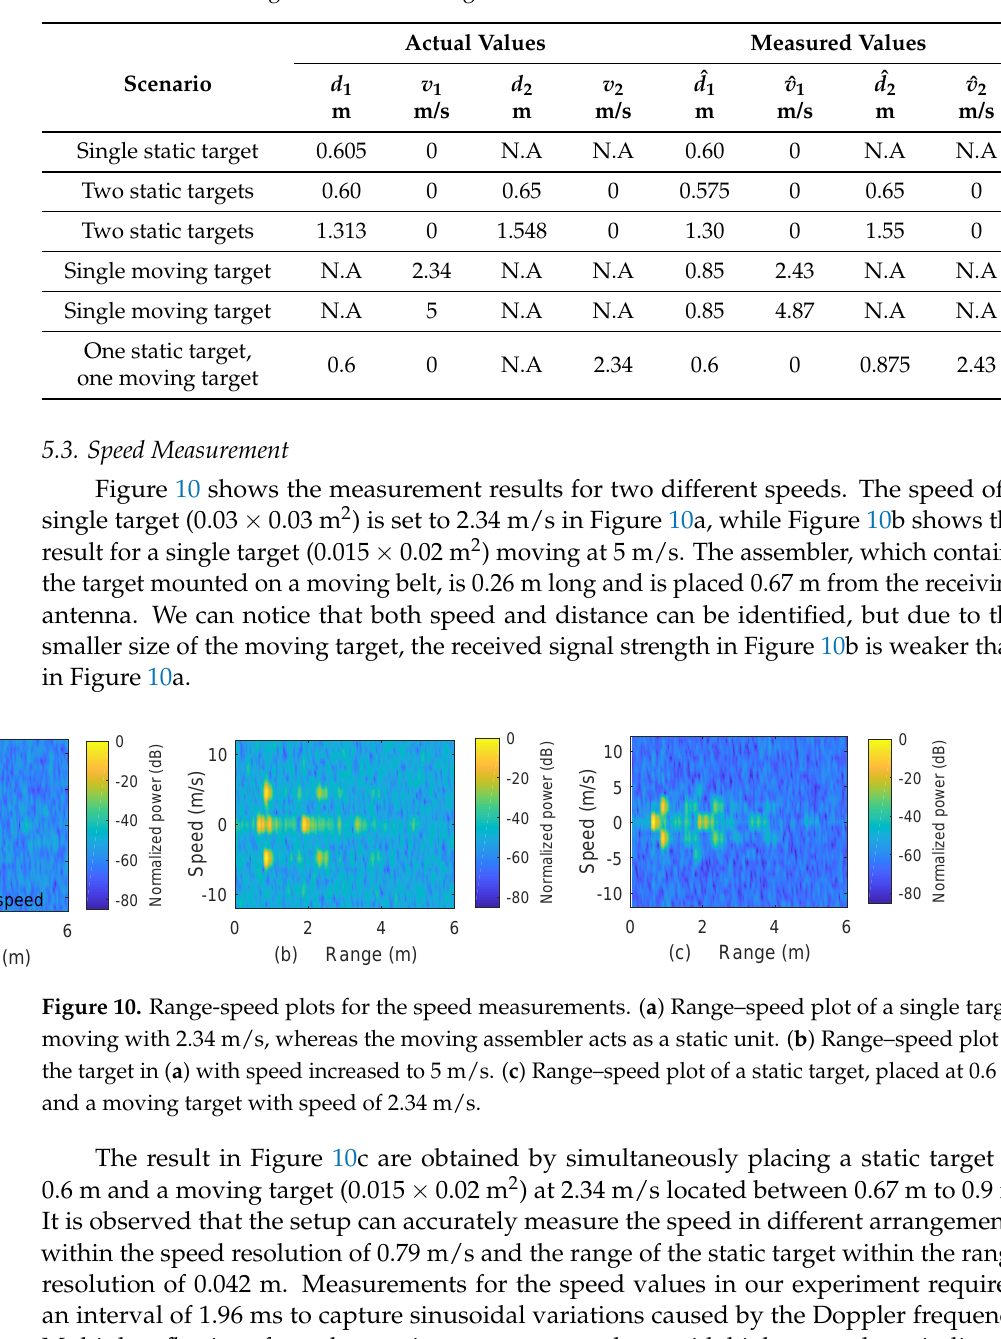
Table 3. Number of targets and their arrangements for different scenarios.